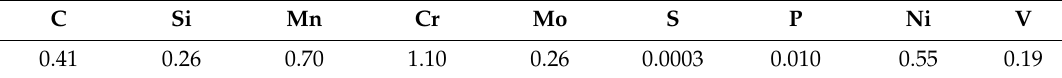
Table 1. Chemical compositions of the experimental medium-carbon low-alloy (MCLA) martensite steel (wt%).